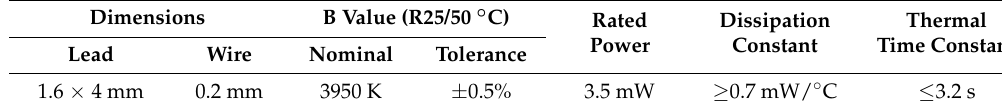
Table 2. Thermistor specifications [31].